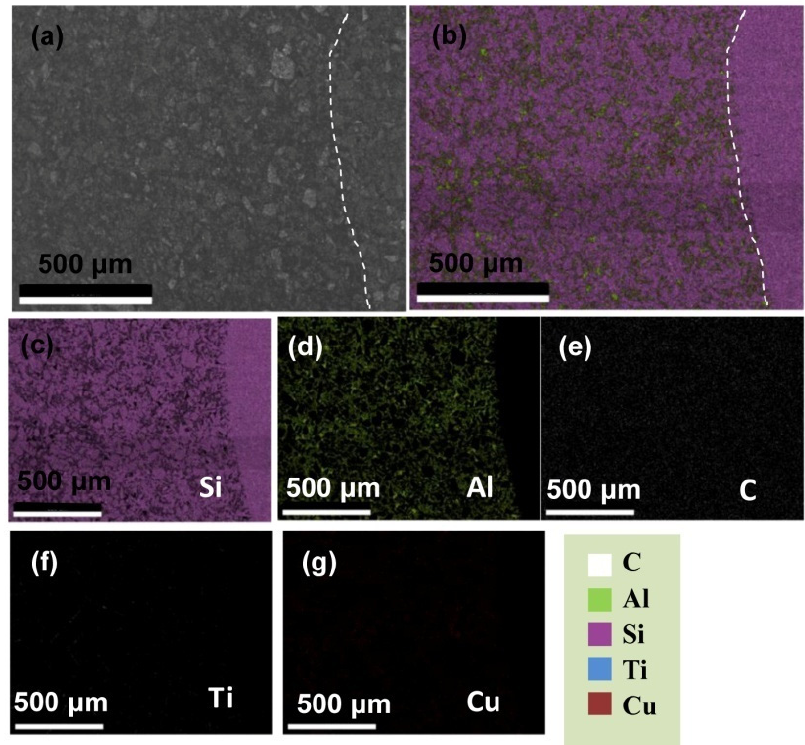
Figure 1. SEM image and element maps of interface of infiltration ( b – g ) and no infiltration ( a ).